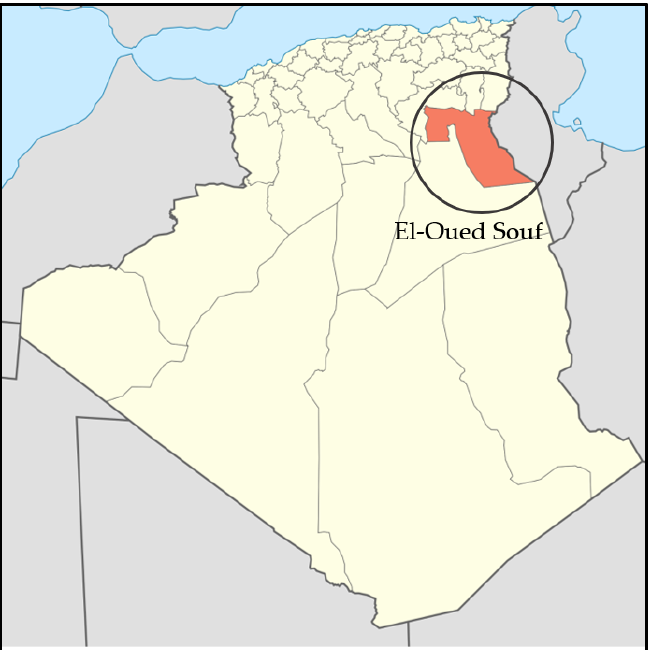
Figure 4. Location of the El-Oued Souf region in Algeria (credit: Wikimedia Commons). In most of the Sahara (but not in the region of El-Oued Souf), the settlements consist of a pattern of clustered and compact courtyard houses two or three storeys high, densely packed together and separated by narrow alleyways and cul de sacs [34]. This structure direct radiation, and the frequent sand and dust storms that hit the area. In the region of El-Oued Souf, the layout is a modular plan of rectangular or square-shaped courtyard houses one storey high and connected together by a regular grid-like pattern of wide sandy streets and narrow alleyways (Figure 5a). Houses are covered by plaster domes or vaults to prevent windblown sand accumulating on the roofs (Figure 5b).